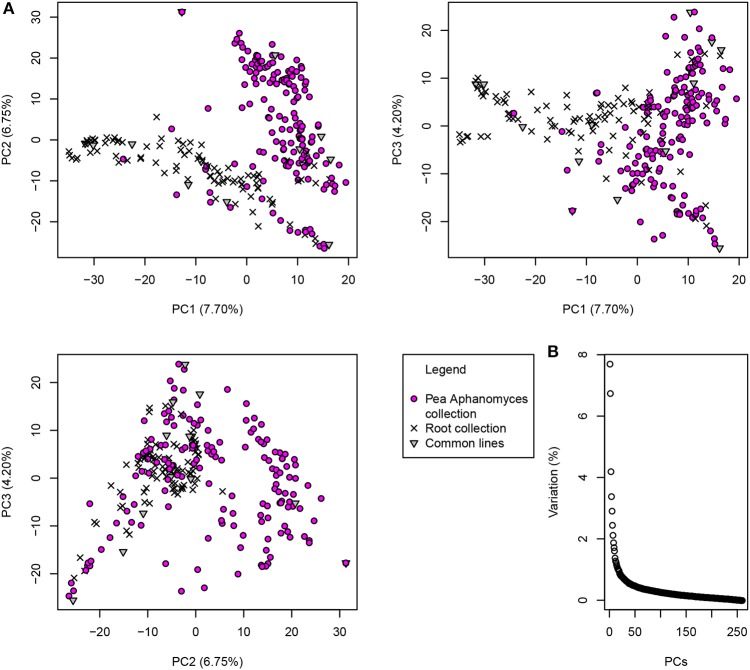
Population structure of the 266-pea-line collection based on the two first axes of the Principal Component Analysis (PCA). PCA was carried out with the GAPIT R package (Lipka et al., 2012), based on 2,937 markers mapped to distinct genetic positions according to Tayeh et al. (2015). (A) Lines from the 266-pea-line collection are represented on the first three principal components that explain a total of 18.65% of inertia. Pea-Aphanomyces collection: 162 pea lines specific to the pea-Aphanomyces collection described in Desgroux et al. (2016); Pea core-collection: 91 pea lines specific to the pea core-collection described in Bourion et al. (2018); Common lines: 13 common lines belonging to both the pea-Aphanomyces collection and the pea core-collection. (B) Inertia contribution of each principal component (from PC1 to PC260).